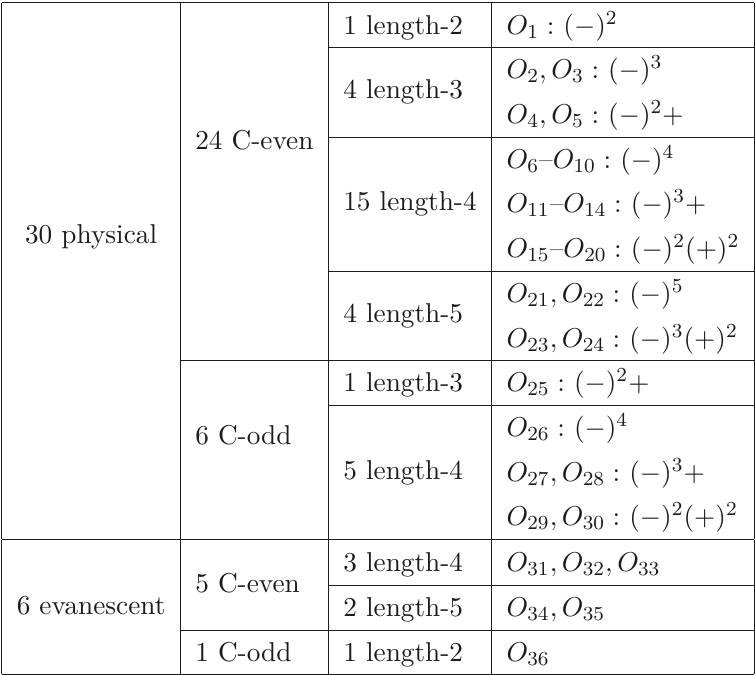
Table 1 . The arrangement of the dimension-10 single-trace operator basis. The subscript i in O i corresponds to the row and column in the Z matrix. We first divide the operators into the physical sector and the evanescent sector. Within each sector, the operators are further classified according to the C-parities, the lengths and the helicities sector